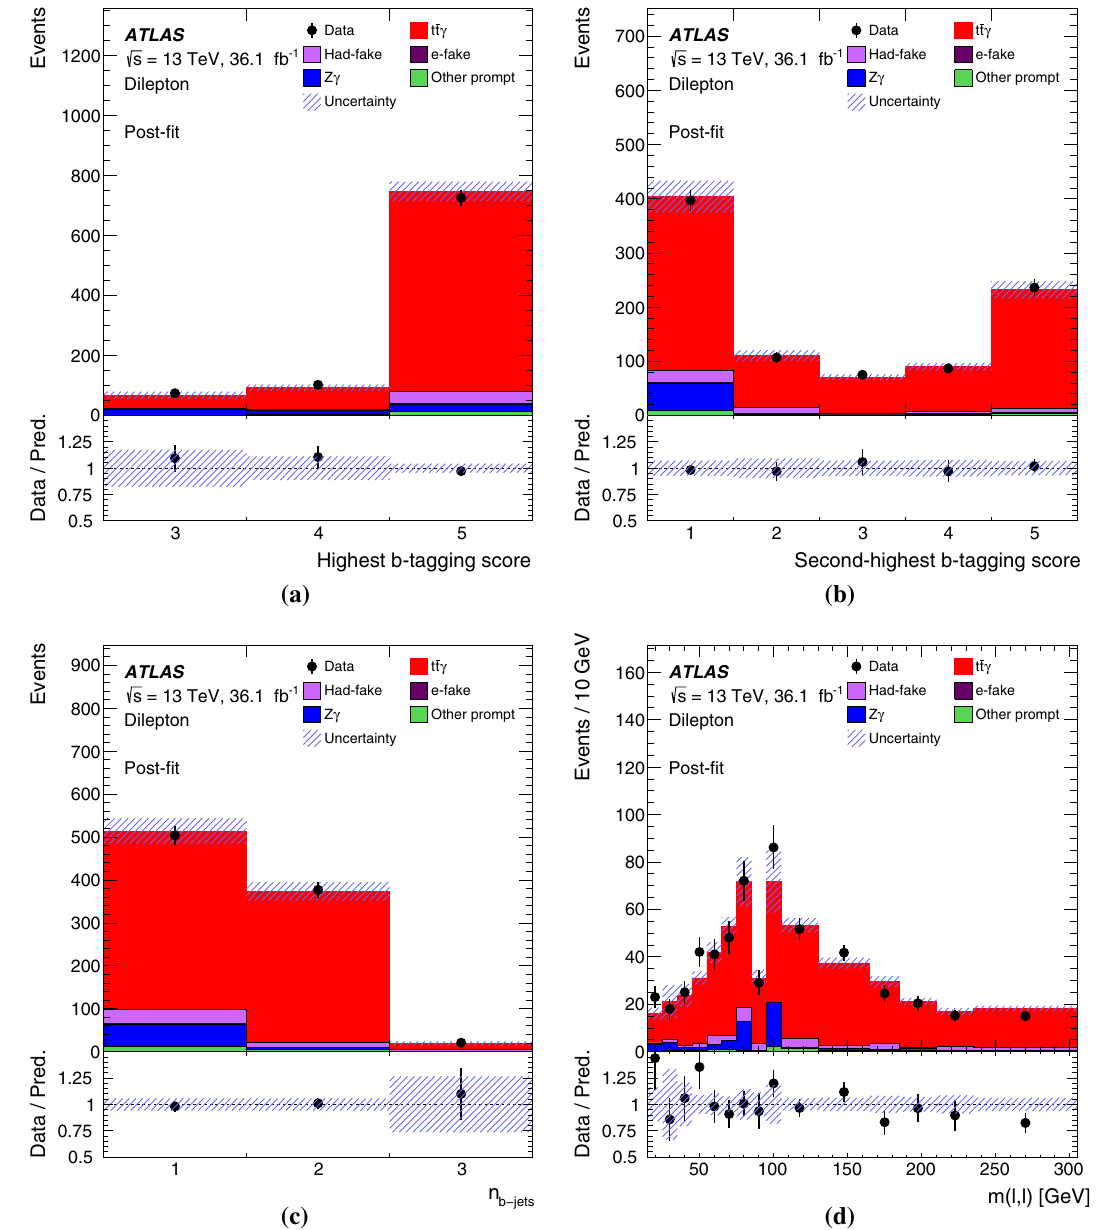
Fig. 15 Distributions of the a highest and b second highest b -tagging scores for all jets, c total number of b -tagged jets (at a 77% efficiency), and d invariant mass between the two leptons in the dilepton channel after event selection and likelihood fit. Each bin of a and b , from one